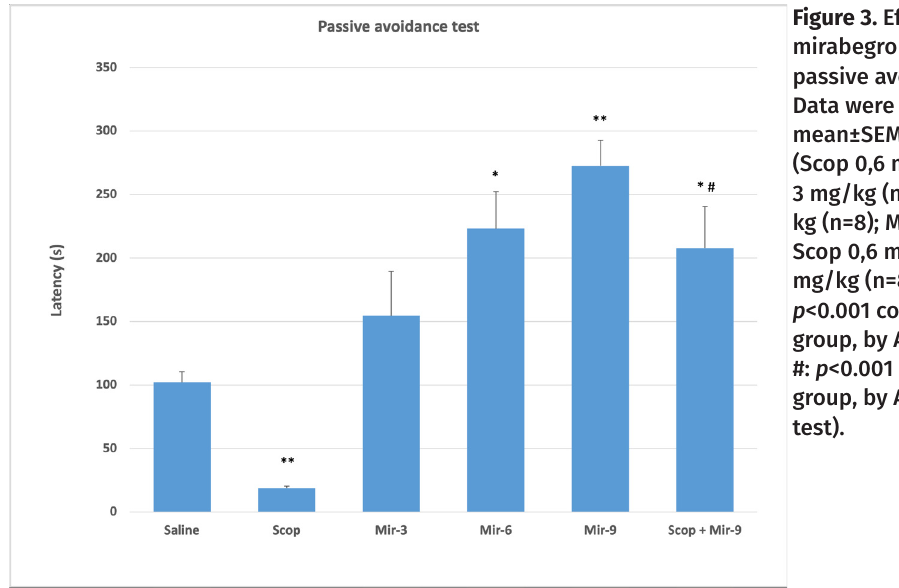
Figure 3. Effects of mirabegron on latency in passive avoidance